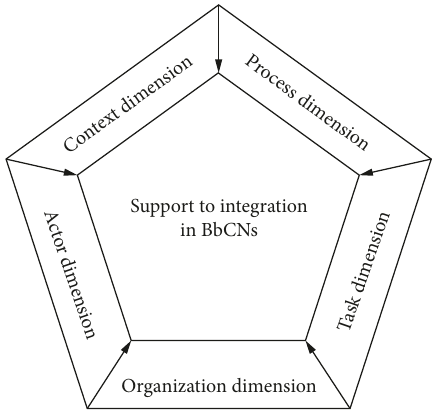
Figure 1: The principal knowledge domains ( integration pentagon ) of BbCNs: a theoretical lens in this